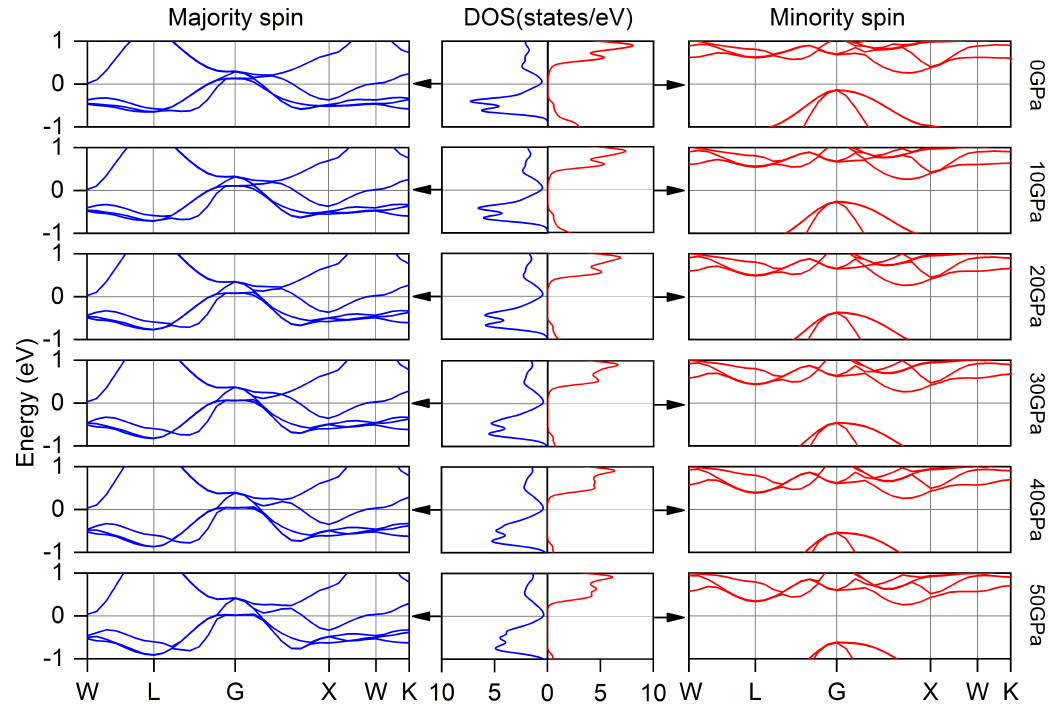
Figure 3. The electronic band structure and total density of states of Ti 2 NiIn compound around the Fermi energy level (0 eV) under different pressure.